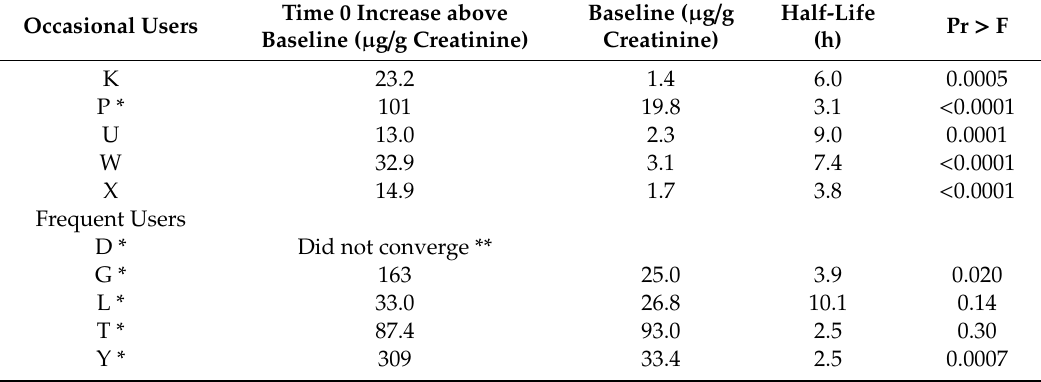
Table 2. Results of the nonlinear exponential fit of creatinine-corrected urinary 2CYEMA concentrations ( µ g / g creatinine) versus time after the beginning of product